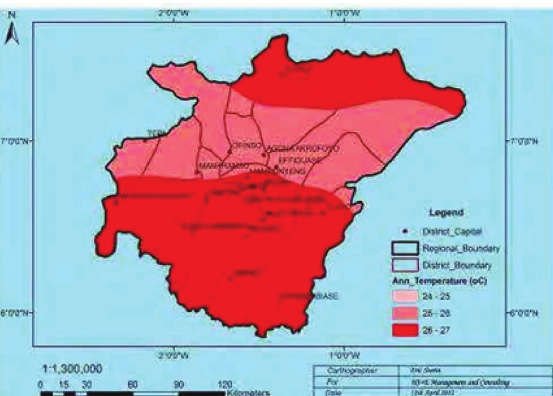
Figure 4: Average annual temperatures in the Ashanti Region (source: